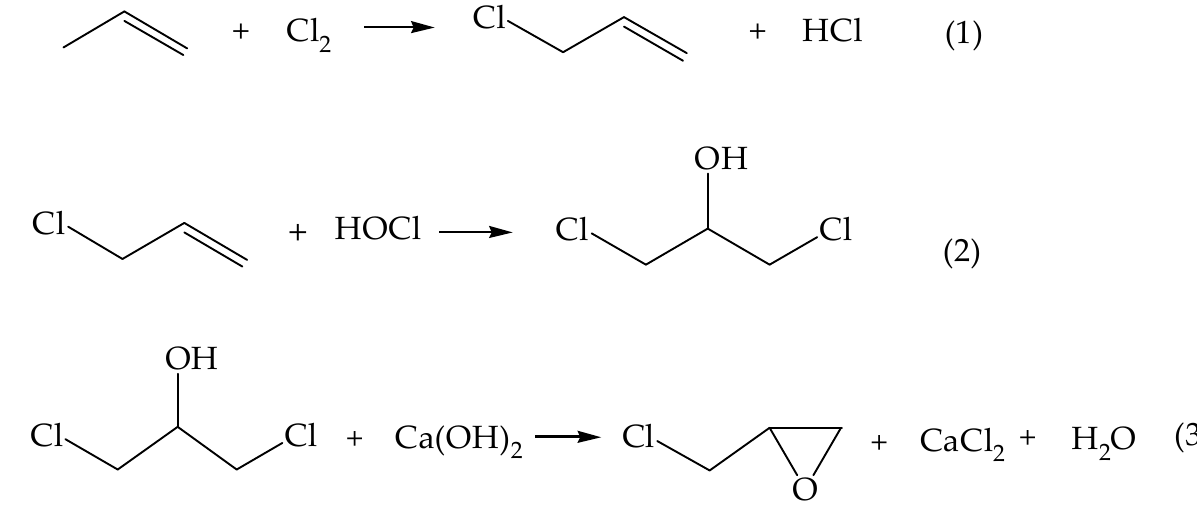
Figure 7. Reaction mechanism of epichlorohydrin synthesis from propene.